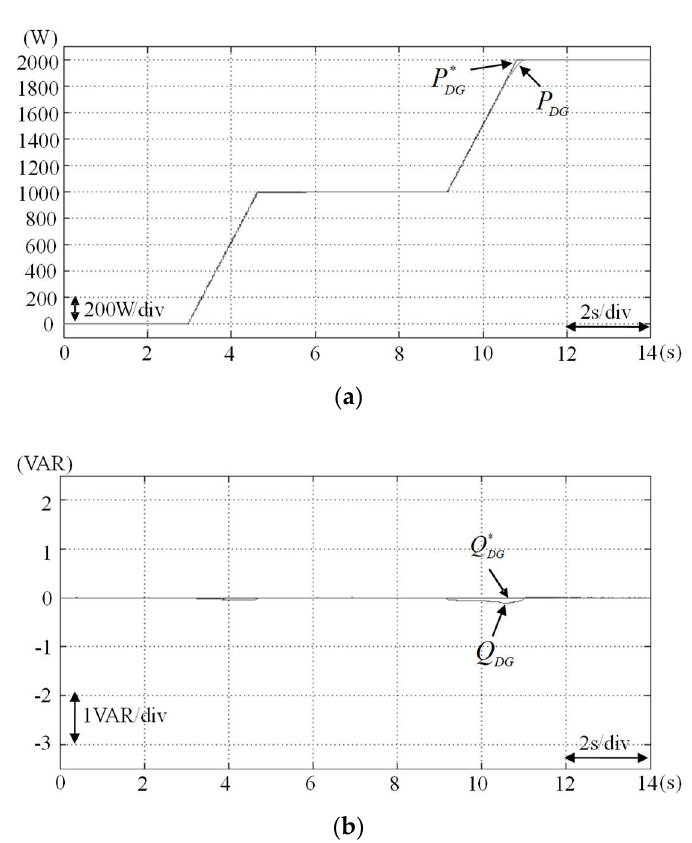
Figure 7. Experimental result of DG using PFNN controllers for active and reactive power control: ( a ) active power Response of; ( b ) Response of reactive power.